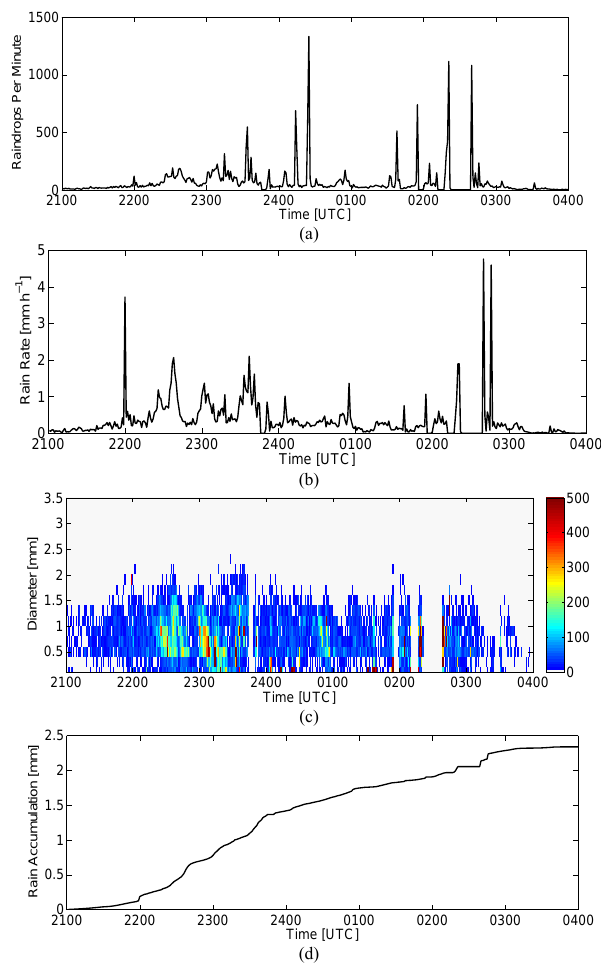
Figure 12. History of rainfall observations from 21:00, 8 May 2013 to 04:00, 9 May 2013